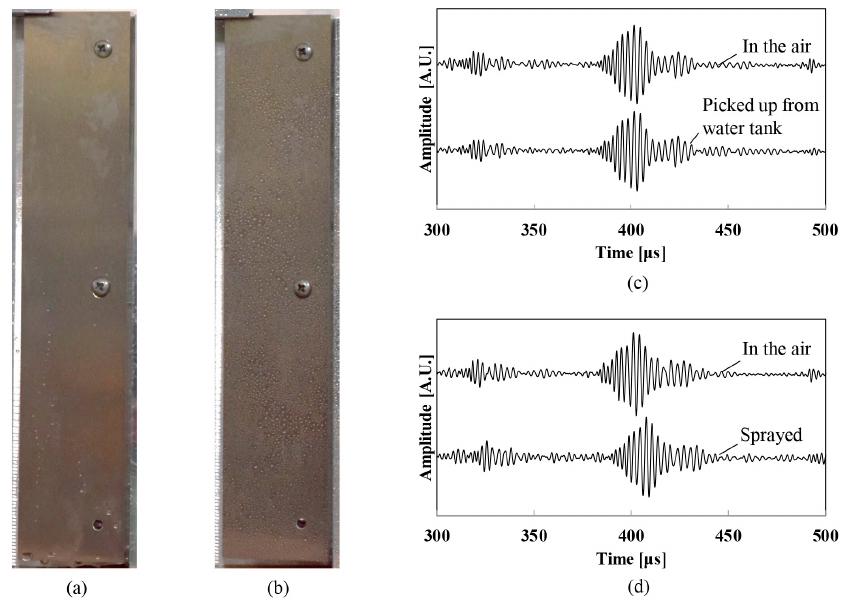
Figure 8. Effect of wet surface. ( a ) Picture of wet waveguide just after being picked up from the water and ( b ) after being sprayed. ( c ) Waveform of wedge wave in the air and just after being picked up from the water. ( d ) Waveform of wedge wave in the air and after water